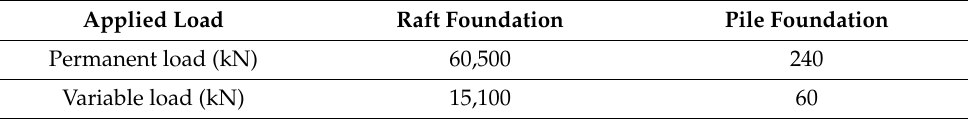
Table 7. Loads applied on the designed